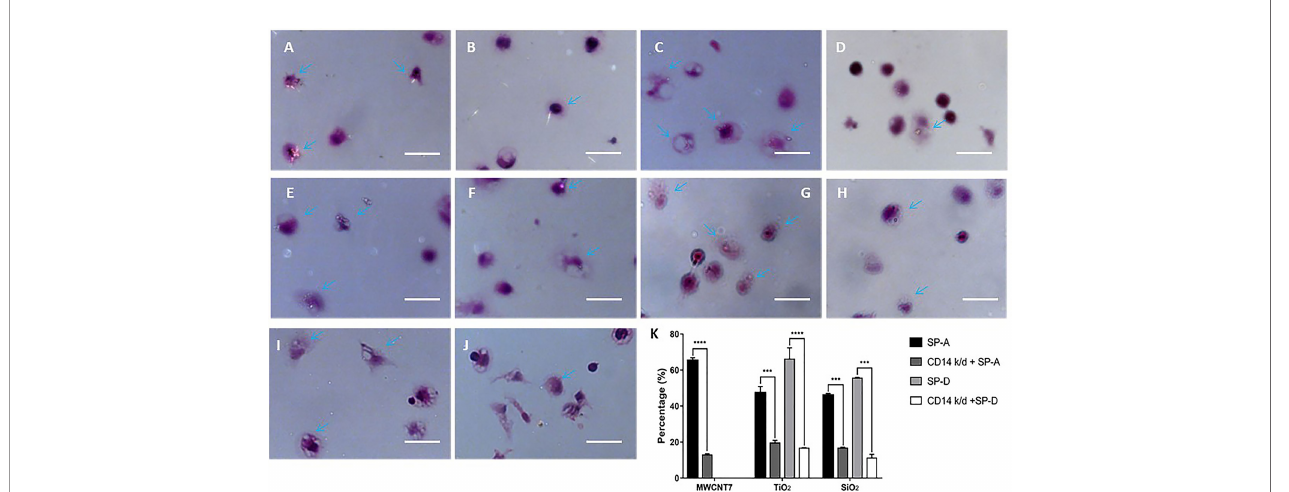
FIGURE 6 | Effect of CD14 knockdown on phagocytosis of MWCNT-7, TiO 2 , and SiO 2 . Polarized light microscope images of primary alveolar macrophages treated with MWCNT-7 pre-incubated with SP-A (A) ; CD14-knockdown primary alveolar macrophages treated MWCNT-7 pre-incubated with SP-A (B) ; primary alveolar macrophages treated with TiO 2 pre-incubated with SP-A (C) ; CD14-knockdown primary alveolar macrophages treated with TiO 2 pre-incubated with SP-A (D) ; primary alveolar macrophages treated with TiO 2 pre-incubated with SP-D (E) ; CD14-knockdown primary alveolar macrophages treated with TiO 2 pre-incubated with SP-A (F) ; primary alveolar macrophages treated with SiO 2 pre-incubated with SP-A (G) ; CD14-knockdown primary alveolar macrophages treated with SiO 2 pre- incubated with SP-A (H) ; primary alveolar macrophages treated with SiO 2 pre-incubated with SP-D (I) ; and CD14-knockdown primary alveolar macrophages treated with SiO 2 pre-incubated with SP-D (J) . Percentages of alveolar macrophages with phagocytosed MWCNT-7, TiO 2 , and SiO 2 were shown (K) . Arrows indicate alveolar macrophages with phagocytosed ENMs; bars = 50 m m. *** and **** represent p values less than 0.001 and 0.0001,